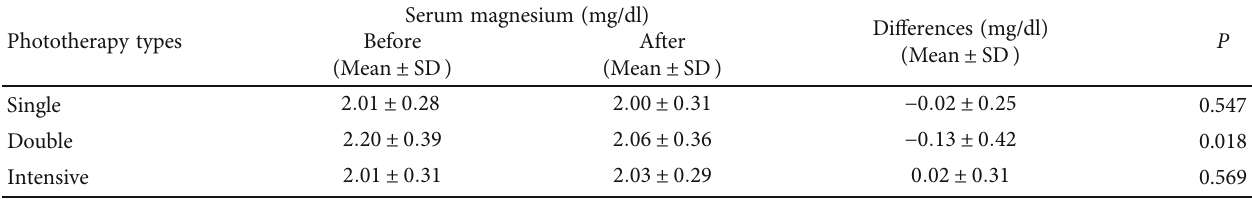
Table 3: Serum magnesium levels before and after single, double, and intensive phototherapy. Phototherapy types